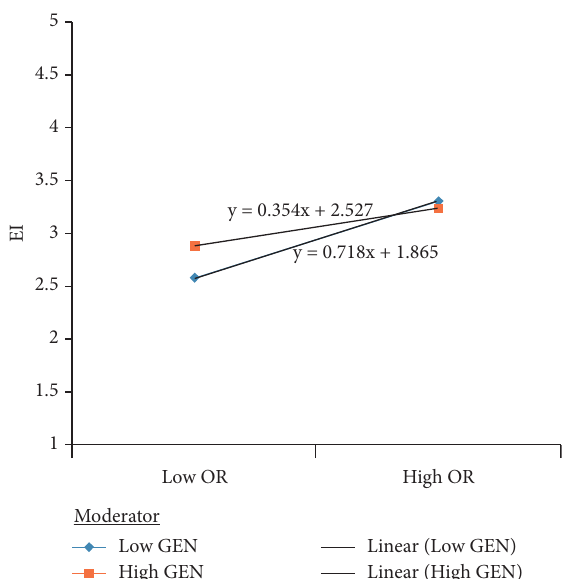
Figure 4: (Graphical presentation of moderation effect of GEN on OR). GEN diminishes the positive relationship between OR and EI.